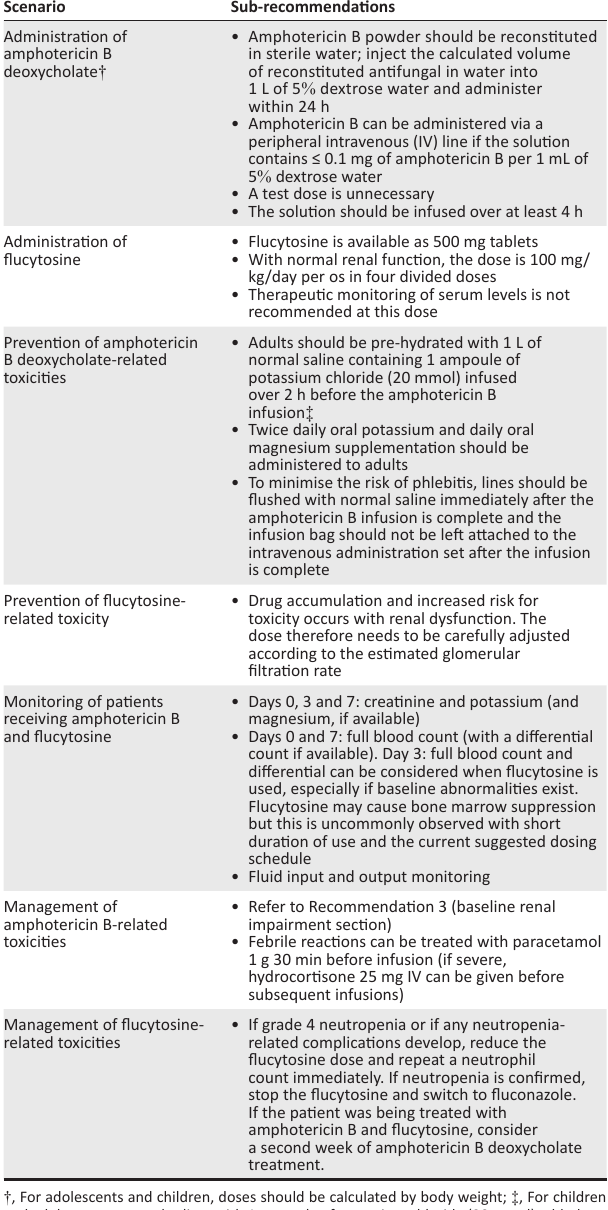
TABLE 7: Summary of recommendation